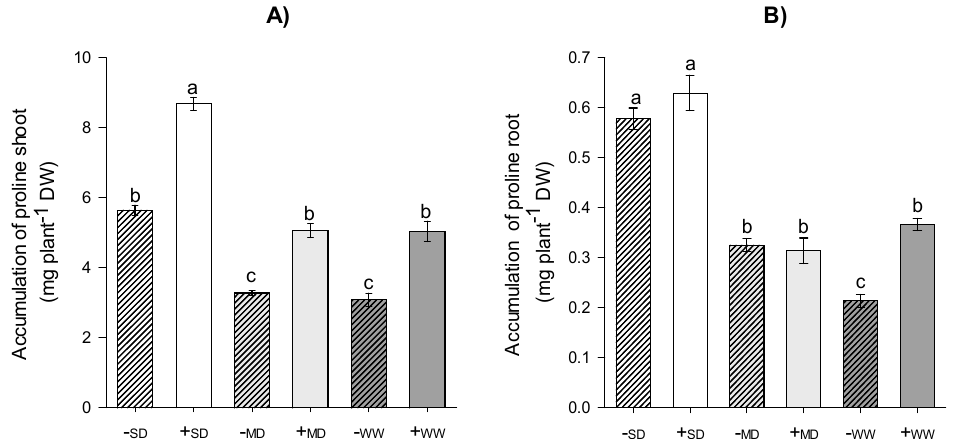
Figure 2. Variation in shoot ( A ) and root ( B ) proline accumulation of H. serratifolius plants submitted to different water regimes in the presence and absence of arbuscular mycorrhizal fungi. -SD: severe water deficit without AMF; +SD: severe water deficit with AMF; -MD: moderate water deficit without AMF; +MD: moderate water deficit with AMF; -WW: well-watered without AMF; +WW: well- watered with AMF. The means of variables with the same letter are not statistically different by Tukey’s test ≤ 5%.